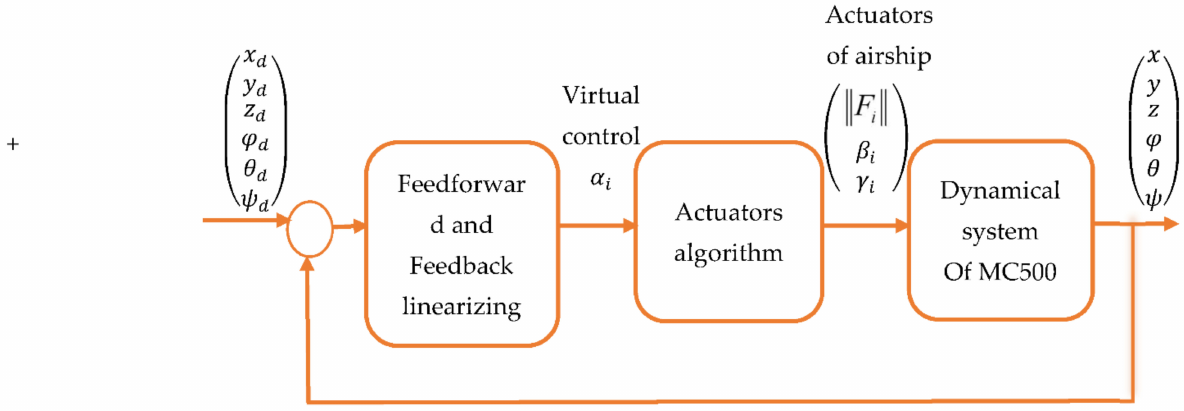
Figure 5. Closed-loop architecture of